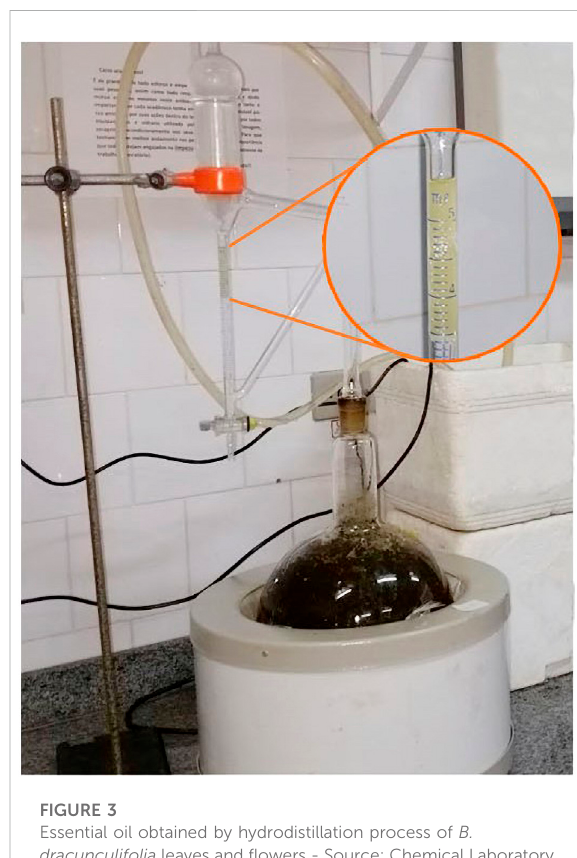
FIGURE 3 Essential oil obtained by hydrodistillation process of B. dracunculifolia leaves and fl owers - Source: Chemical Laboratory of Natural Products-Paranaense University-UNIPAR, Brazil. Source: The Authors.